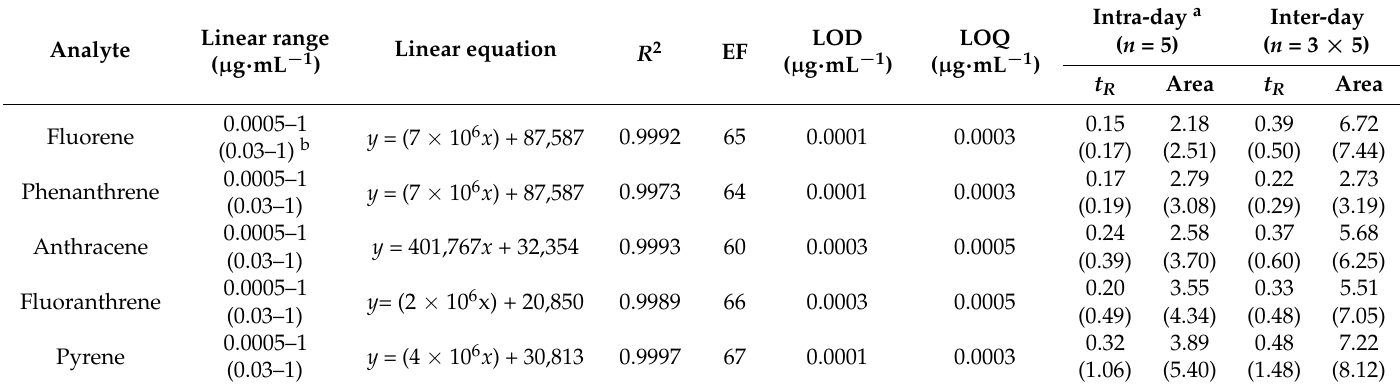
Table 1. Analytical performance of magnetic stirring assisted demulsified dispersive liquid–liquid microextraction method for determination of polycyclic aromatic